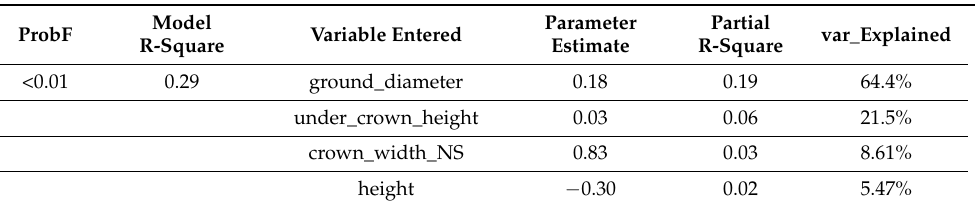
Figure 3. Relationship between green nut yield per tree and ( a ) north–south crown width (m), ( b ) 2 ), and ( d ) ground diameter (cm). east–west crown width (m), ( c ) crown area (m 2 ), and ( d ) ground diameter (cm). ( b ) east–west crown width (m), ( c ) crown area (m Table 2. Stepwise linear multivariate model predicting green nut yield per tree with morphological factors.